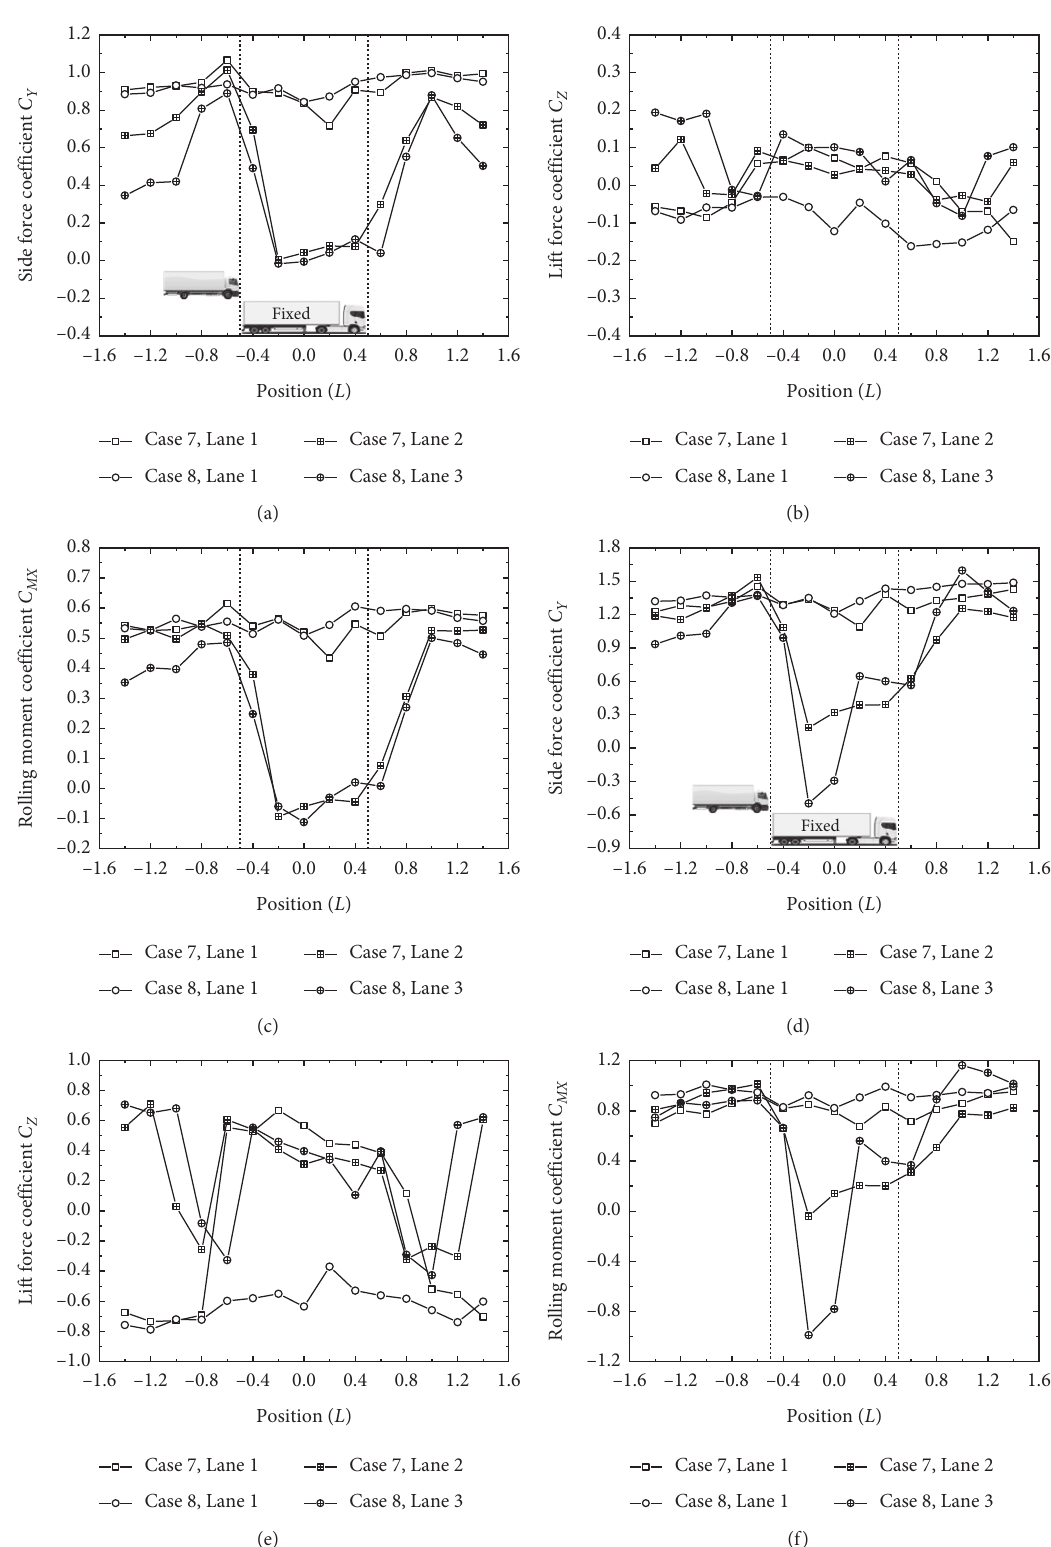
Figure 9: Aerodynamic coefficient of the van affected by lorry ((a), (b), (c) mean; (d), (e), (f) 3 s